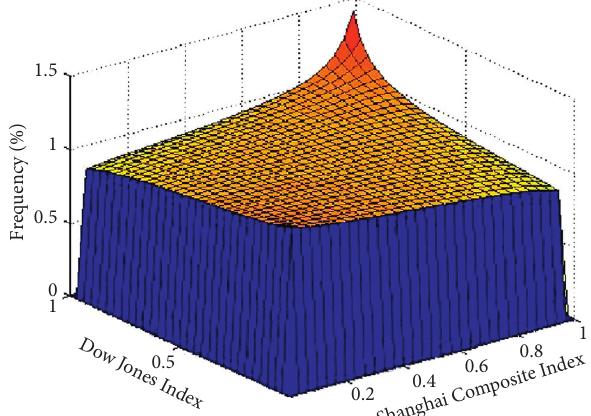
Figure 6: Gumbel Copula distribution of SSE index and Dow Jones Index extreme volatility series based on B segment weekly data.